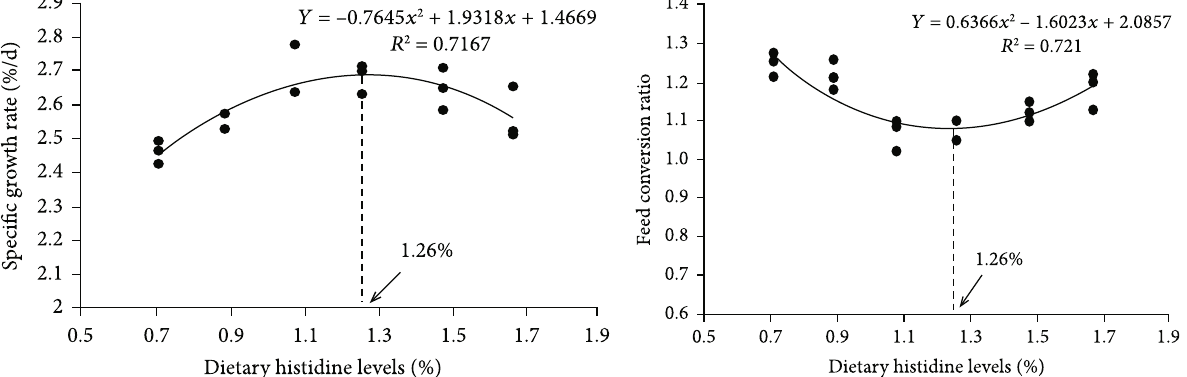
Figure 1: Quadratic regression analysis of speci fi c growth rate (SGR, %/day) and feed conversion rate (FCR) against graded di ff erent levels of dietary